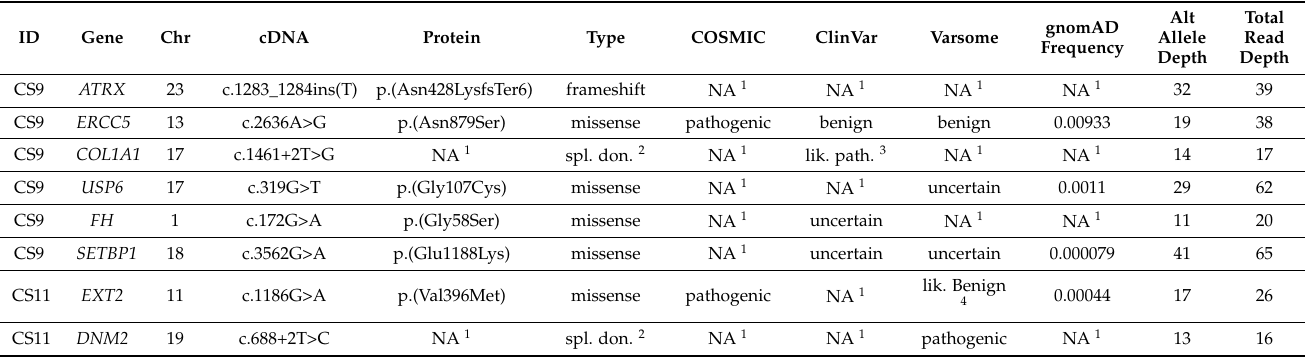
1 NA = not available; 2 spl. don. = splice donor; 3 lik. path. = likely pathogenic; 4 lik. benign = likely benign. The ERCC5 gene presented a missense mutation (c.2636A>G) on chr13:102868215 (exon 12), where a Serine replaced an Asparagine at position 879 (Table 2). According to SIFT, this ERCC5 variant is deleterious and probably damaging according to PolyPhen. Moreover, on COSMIC, the alteration is classified as somatic, and its FATHMM prediction is pathogenic with a score of